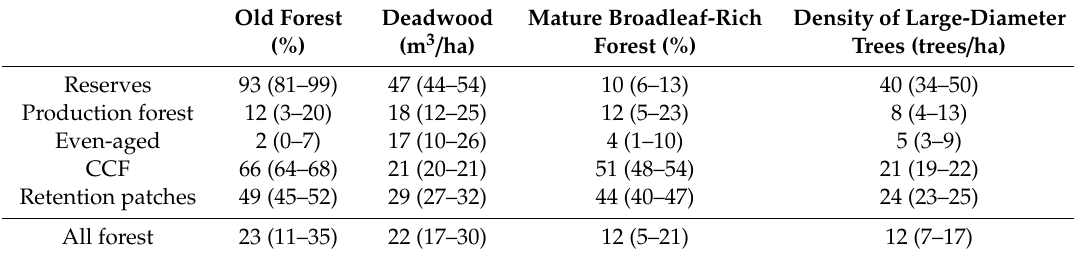
Table 5. Mean (and range, in brackets) of the ecological indicators, per forest type and management regime and across the stakeholder scenarios, after 100 years of simulation.